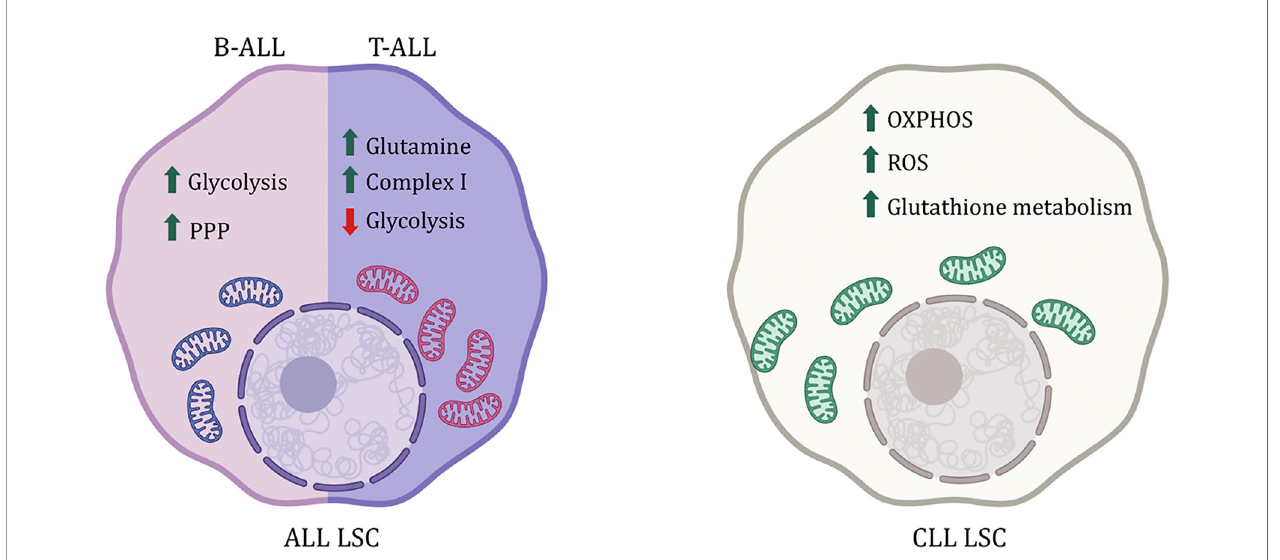
FIGURE 3 | Metabolic difference between ALL and CLL LSCs. B-ALL LSCs are reliant on Pentose phosphate pathway (PPP) and glycolysis where as T-ALL LSCs rely more on glutamine metabolism. CLL on the other had sees an increase in ROS and is reliant on OXPHOS. Increase in glutathione metabolism is also reported as an antioxidant to the high amount of